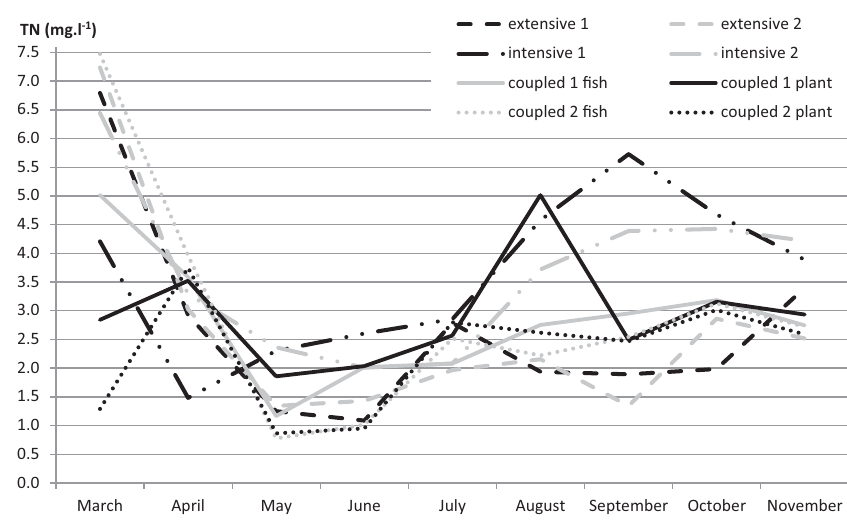
Fig. 5. Total nitrogen (TN) dynamics in the water during the rearing period in two replicates of carp polyculture ponds: extensive (without formulated feed), semi-intensive (with feed and double fi sh density) and coupled (semi-intensive ( fi sh) þ planted lagoon (plant)).